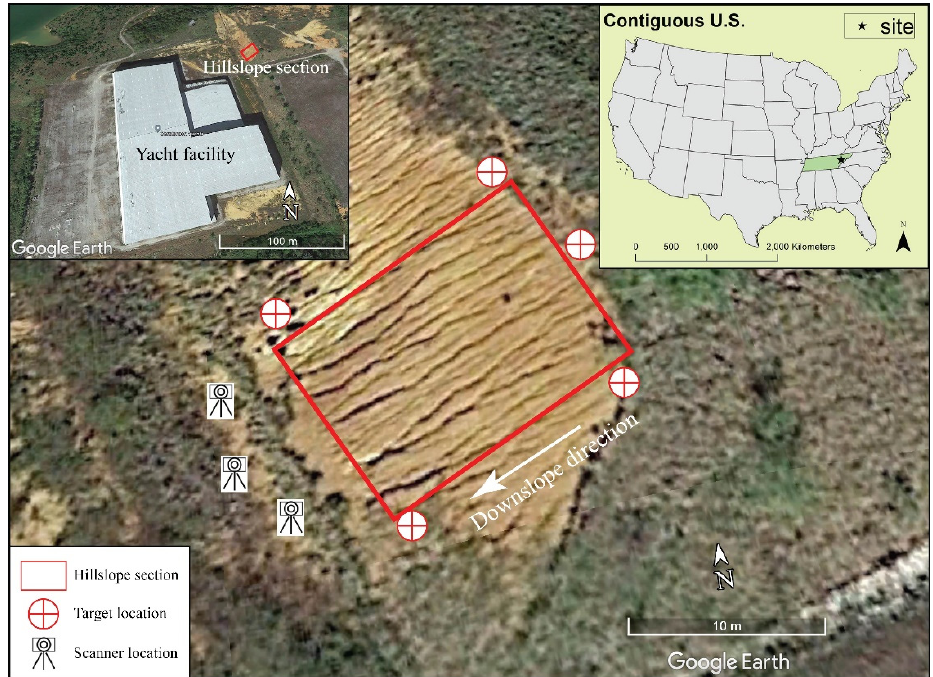
Figure 1. A Google Earth bird’s-eye view of the 18 m × 14 m 27° rilled hillslope in Loudon County, Tennessee, showing the three terrestrial laser scanner (TLS) locations for collecting microtopographic data. The locations of five targets are also illustrated to register the TLS scans. The inset map on the left shows the yacht facility near this site: the permanent features of this building, such as walls and corners, were used for the registration of point clouds from different times. The inset map on the right shows the site location in the United States.